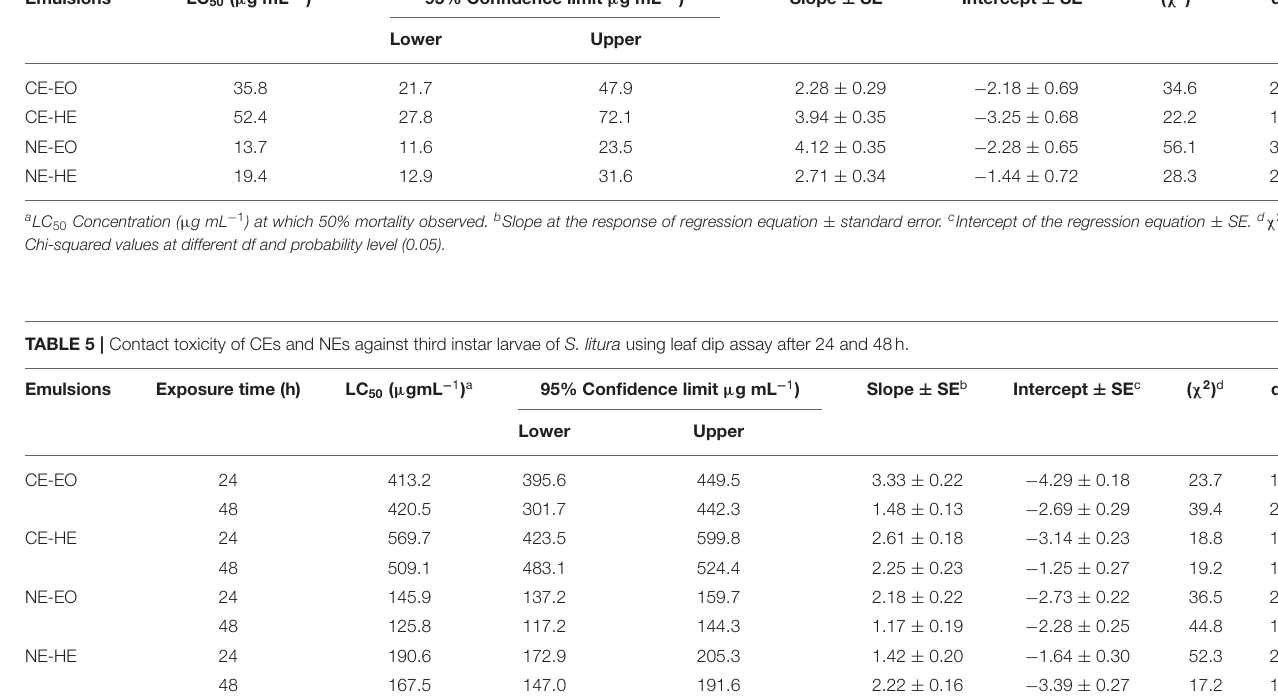
TABLE 4 | Fumigant activity of CEs and NEs against the adults of T. urticae after 24h of treatment. Emulsions